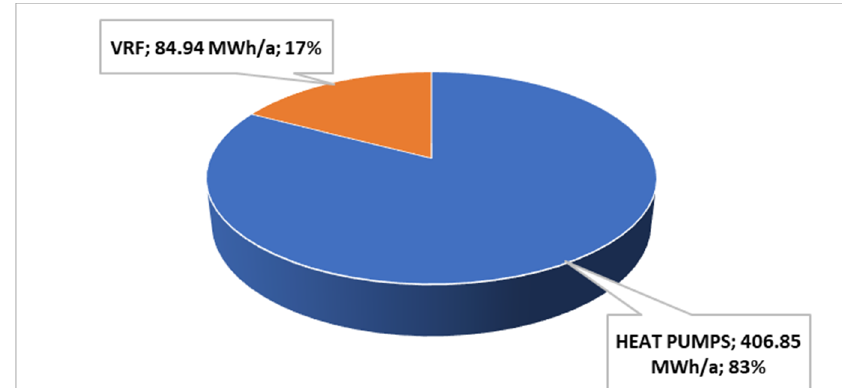
Figure 14. Electric power yearly consumption.